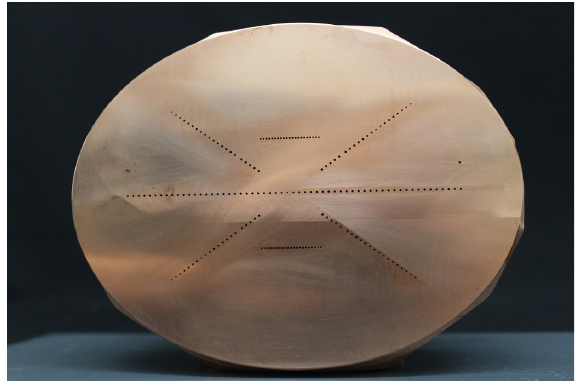
alignment was limited by the coupled tilt and o ff set of the input beam. The gyrotron power was 0.5 MW with pulse lengths up to 400 ms. Fig. 8 shows the measured signals along with theoretical predictions. A good agreement to the maximum signal from the center channel can be seen. Before the start of the measurements there was just a rough pre-alignment wih an LCD-target, so it does not indicate the accuracy of the mentioned laser adjustment at ASDEX Upgrade (see Sect. 1).